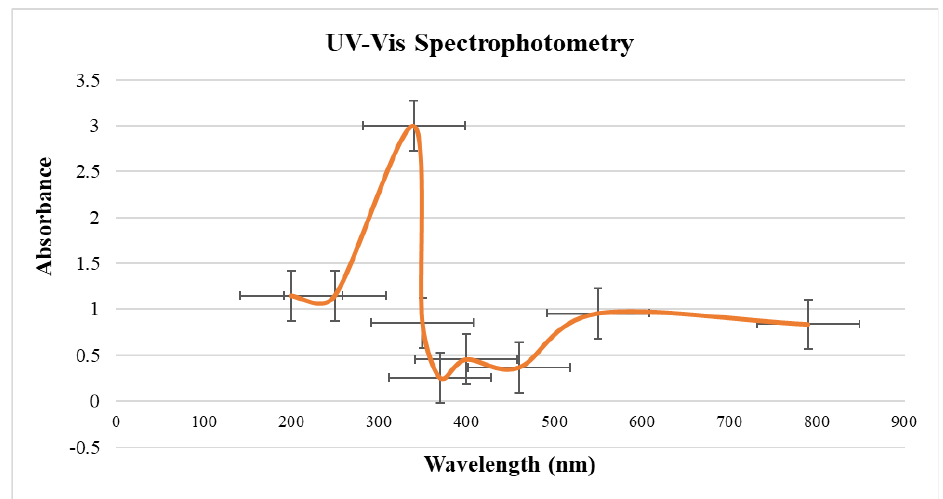
Figure 3 . UV visible spectroscopy for ZVI - NPs synthesized using Nigella sativa seed extract synthe- Figure 3. UV visible spectroscopy for ZVI-NPs synthesized using Nigella sativa seed extract synthe- sized from 25 mM precursor solution of FeCl 3 . sized from 25 mM precursor solution of FeCl 3 .